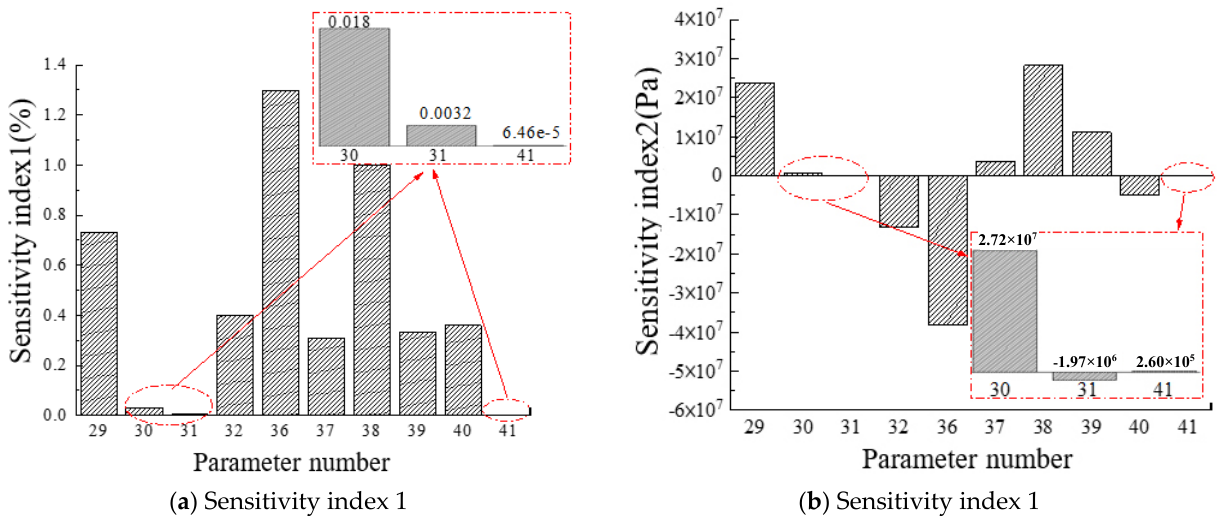
Figure 16. The sensitivity index resulting from return oil part parameter variation.